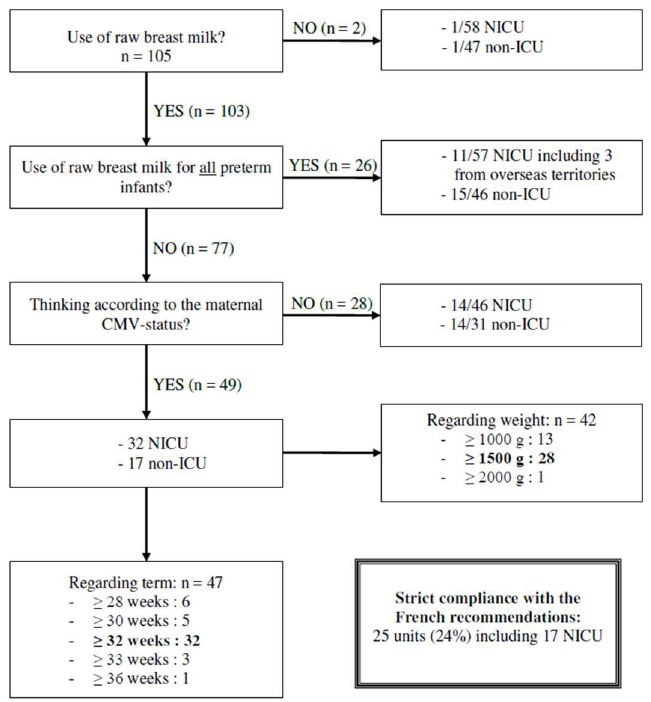
Figure 2. Summary of the current use of raw breast milk in France.